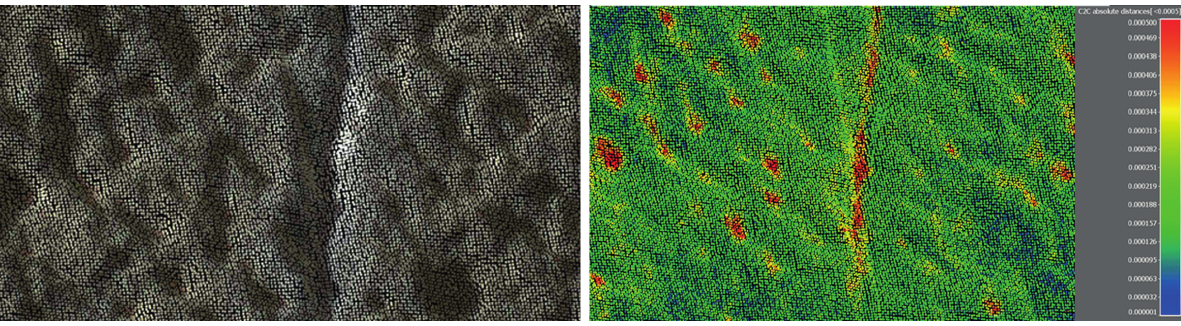
Figure 7. On the left, a detail of the points cloud by images with diffused and grazing lights. On the right, the comparison between the points cloud obtained from photos with diffuse light only and that with diffuse + grazing lights. The red areas show the best reconstruction of the excavated parts.